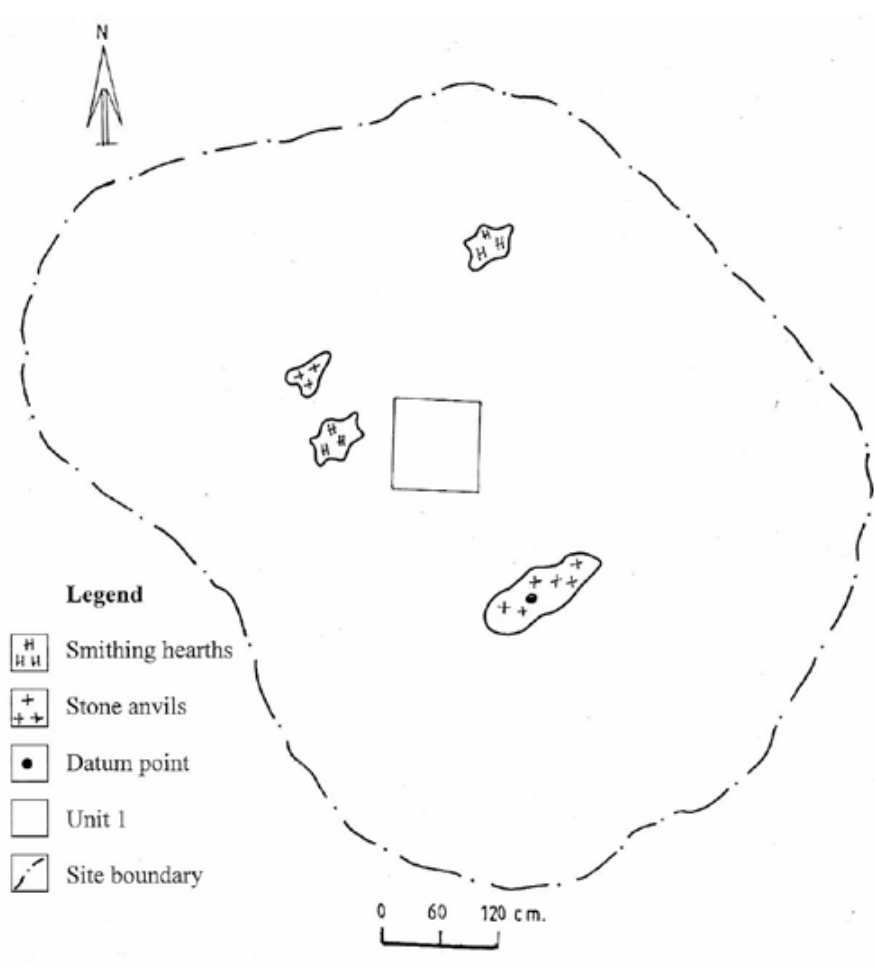
Fig 9: The plan of Nundu ST1